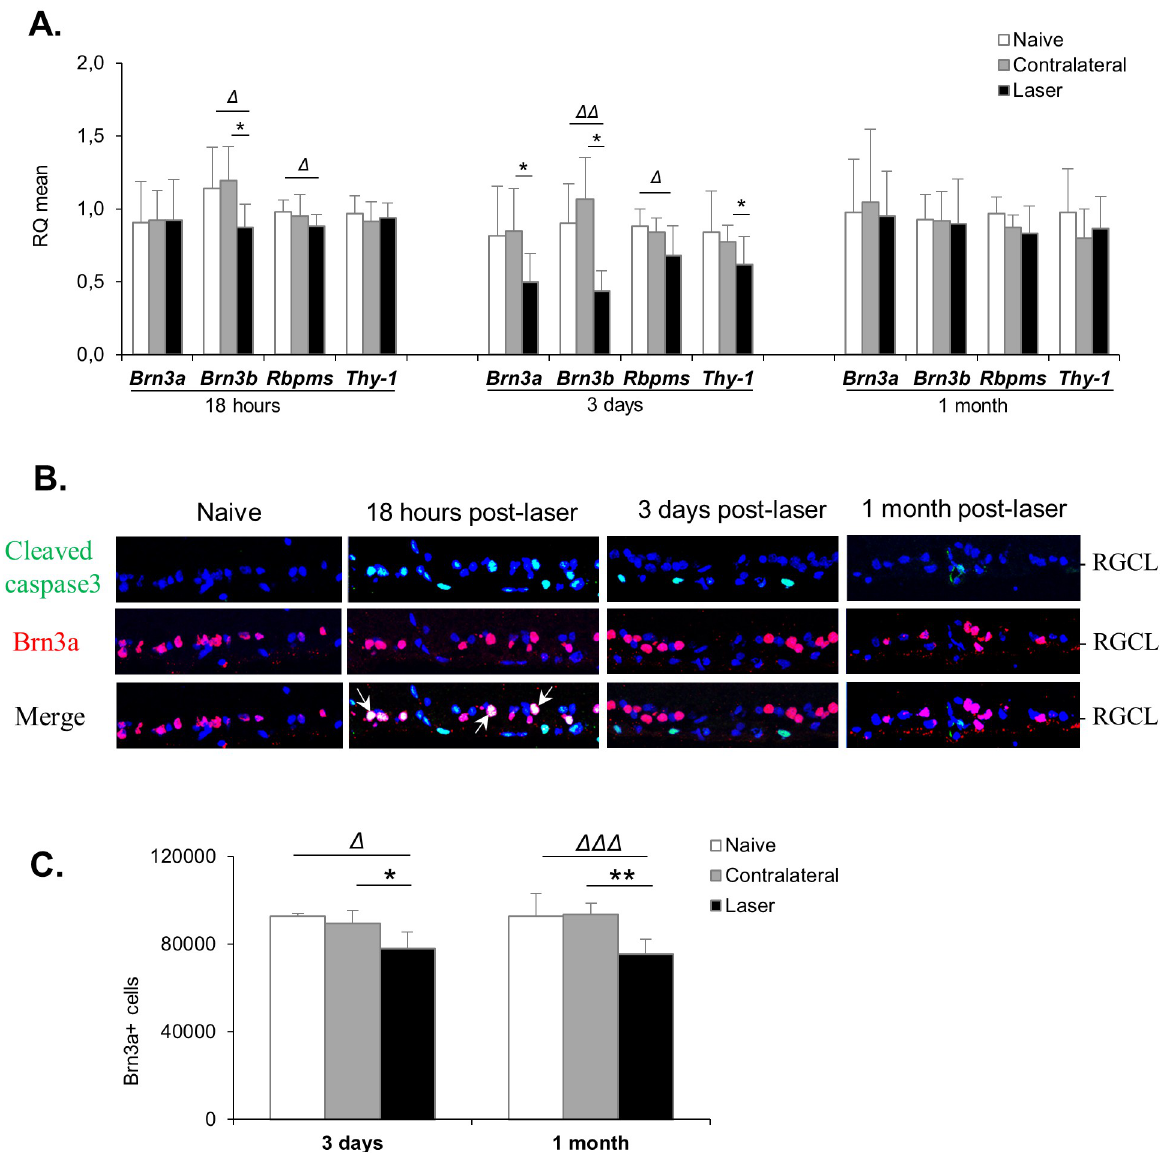
Fig 3. Laser-induced IOP elevation triggers retinal ganglion cell death. (A) Gene expression was assessed using quantitative RT-PCR on retinas collected at 18 hours, 3 days or 1 month after laser photocoagulation. Data were analysed using the 2 - ΔΔ CT method. For statistical analysis: Δ p < 0.05, ΔΔ p < 0.01 vs naive (Mann-Whitney test), � p < 0.05 vs contralateral (Wilcoxon matched-pairs signed rank test). (B) Activated cleaved- caspase 3 and Brn3a immunostaining was performed on retina cryosections showing apoptotic RGCs at 18 hours post-laser. White arrows, example of cleaved-caspase3/Brn3a co-stained cells. Images shown are representative of n = 6–8 retinas. (C) The number of RGC was assessed by counting the total number of Brn3a-positive cells on flatmounted retinas 3 days or 1 month post-laser. Results are expressed as Brn3a-positive cells / mm 2 and presented as mean ± S.D, n = 6 retinas for each group at 3 days, and n = 8 retinas for each group at 1